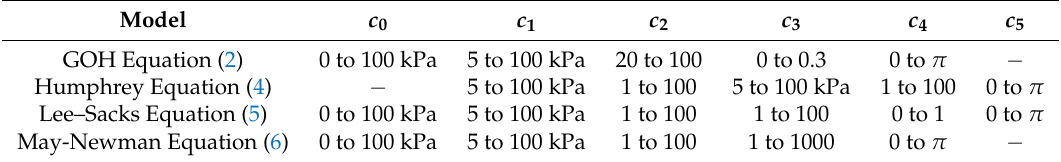
Summary of the models used and the ranges of associated parameters. GOH = Gasser-Ogden-Holzapfel